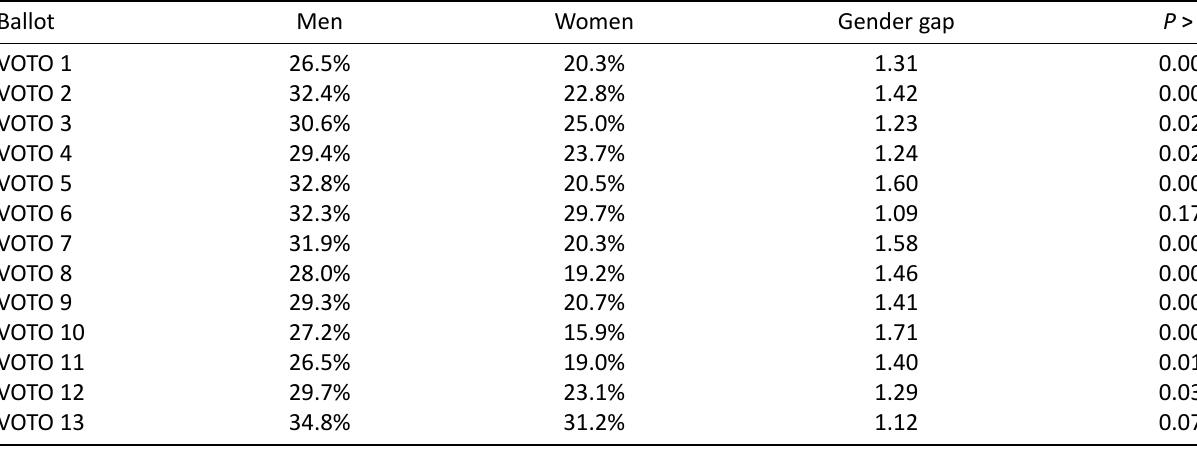
Table 2. The magnitude of the gender gaps in social media use by ballot.